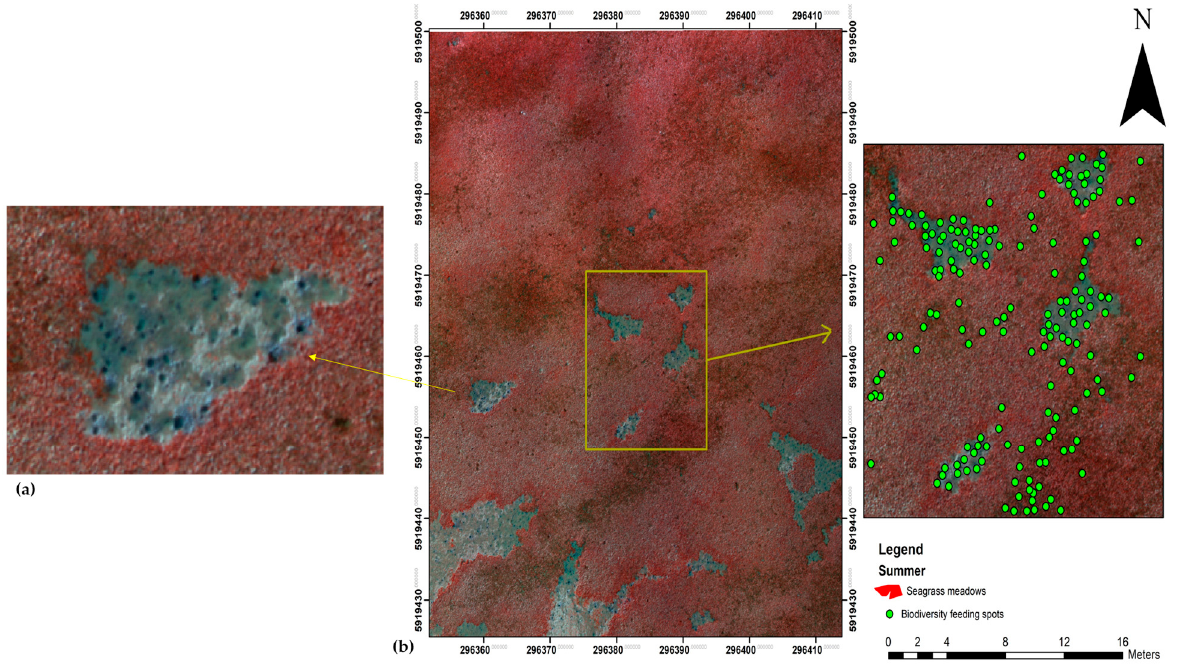
Figure 5. ( a ) A zoomed-in section from the summer aerial imagery showing an example of feeding burrows. ( b ) Digitized feeding burrows symbolized as green dots in ArcMap.